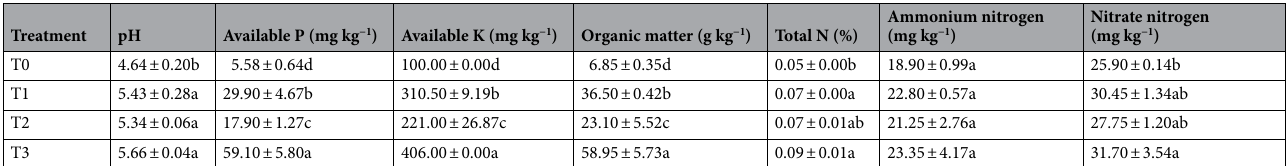
Table 3. Chemical properties of the mixture of rice husk ash and red soil with various proportions.